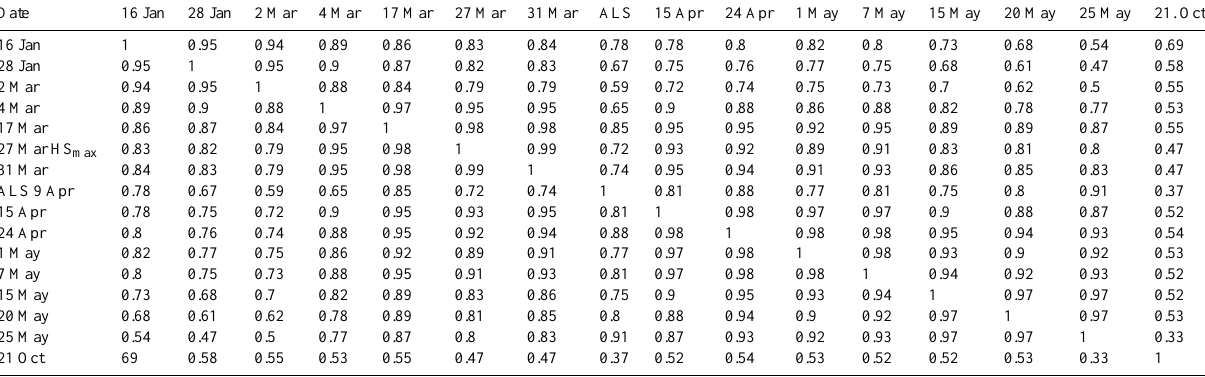
Table 4. Persons Correlation coefficients between snow depth (HS) distributions in the rock face Ch¨upfenflue on different days in 2009.